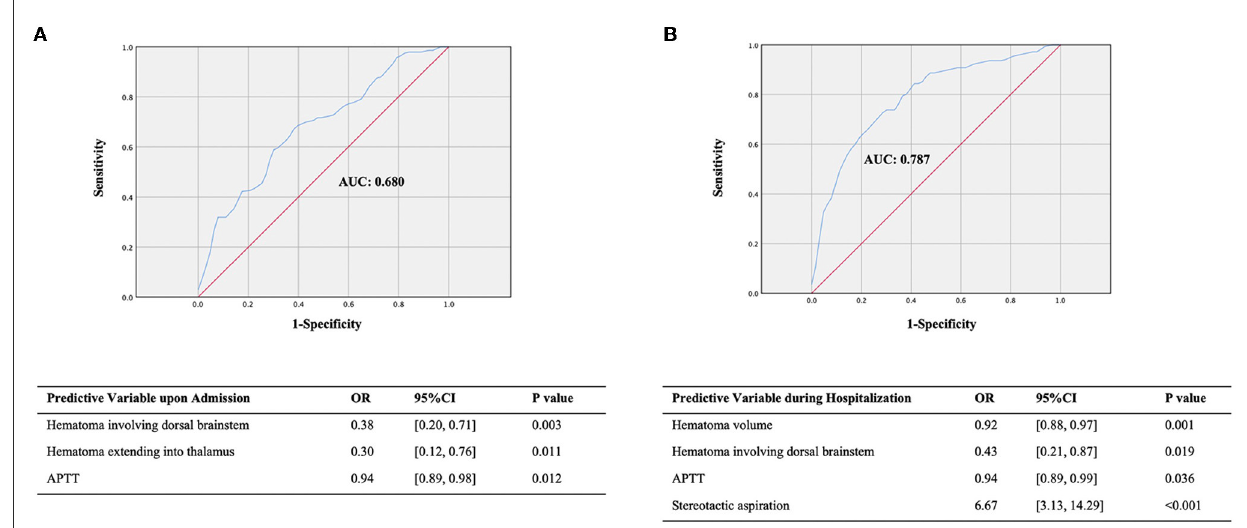
FIGURE3 ROC of the prediction model for the 30-day survival outcome. (A) The prediction model for the 30-day survival outcome upon admission. (B) The prediction model for the 30-day survival outcome during